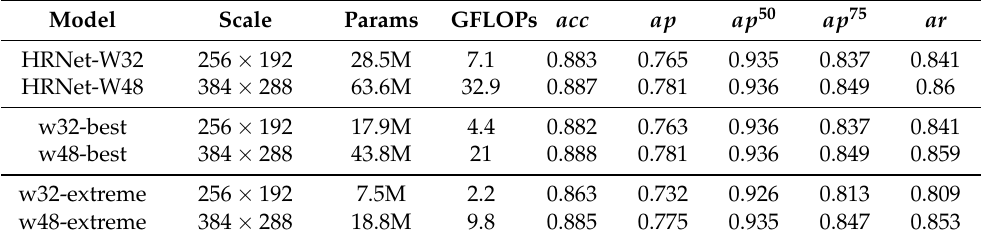
Table 4. COCOVal2017 dataset test results.